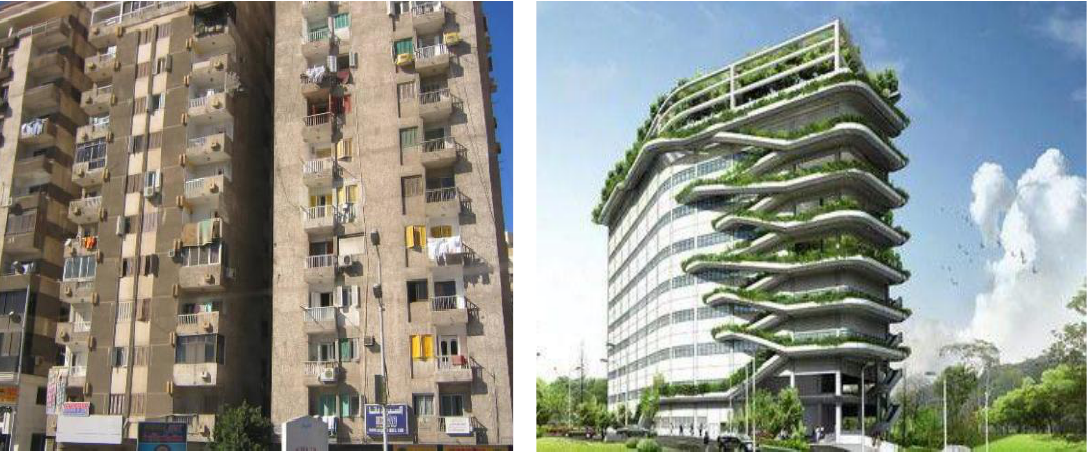
Fig. 5. An example of typical operational residential building in Iraq on left side while a proposed modern sustainable and self-healing based green building architecture on the right side ( Tsangouri et al., 2015)